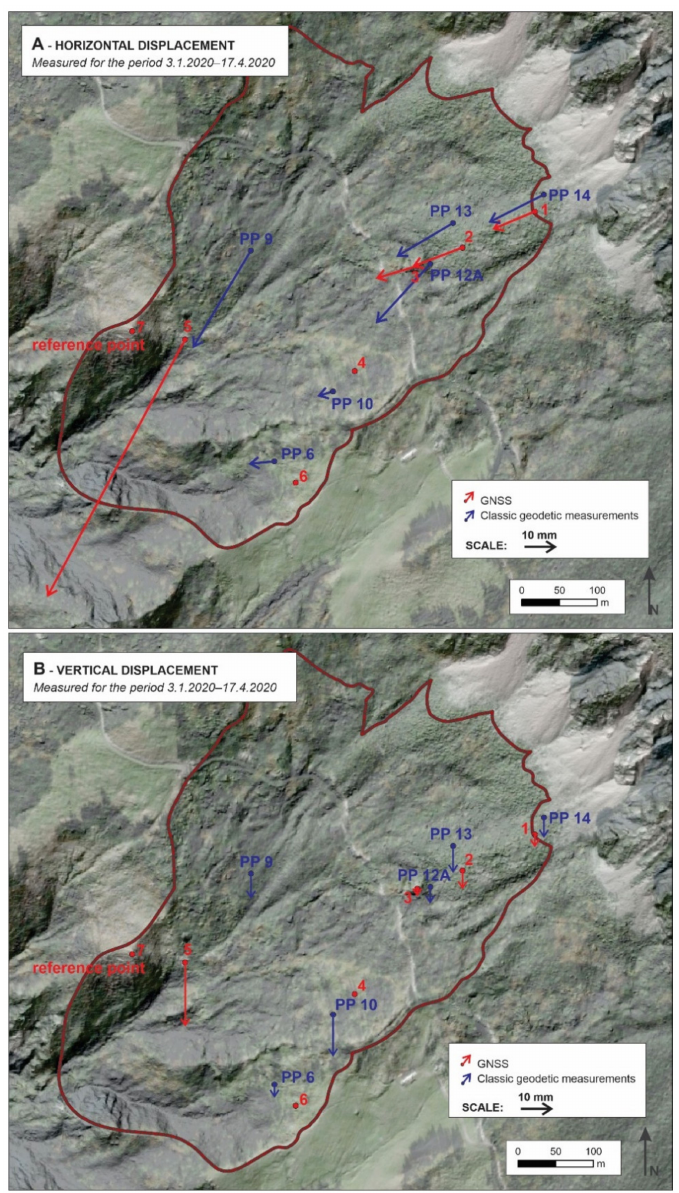
Figure 9. Displacements measured at GNSS units and geodetic points. Table 3. Total horizontal and vertical displacements for all units for the period 7 November